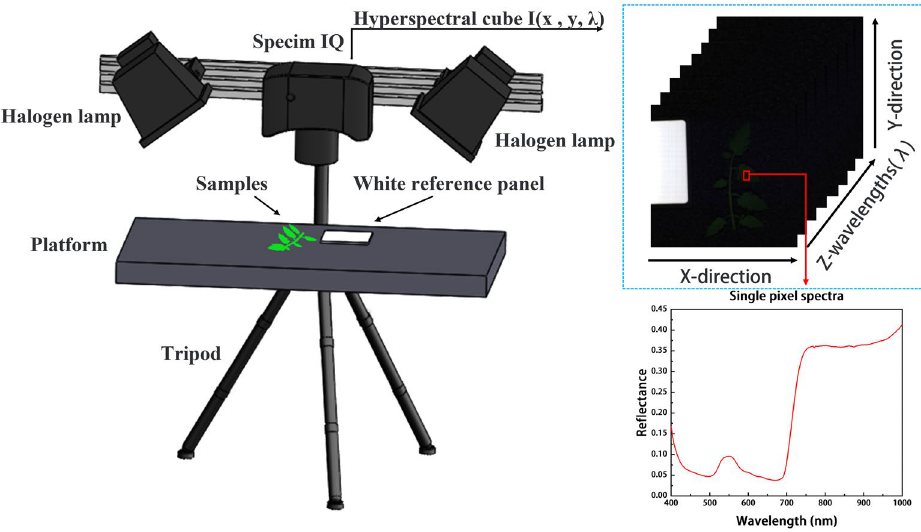
Figure 9. 3D structure of the hyperspectral imaging